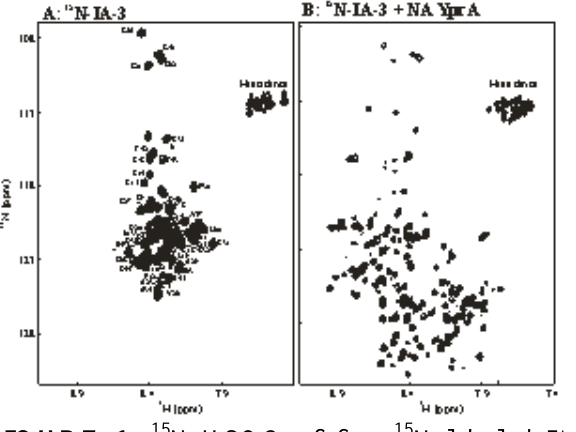
FIGURE 1 . 15 N-HSQC of free 15 N-labeled IA (right). The spectrum on the right was obtained from the sample shown on the left by adding an approximately stoichiometric amount of unpurified YprA (Sigma).